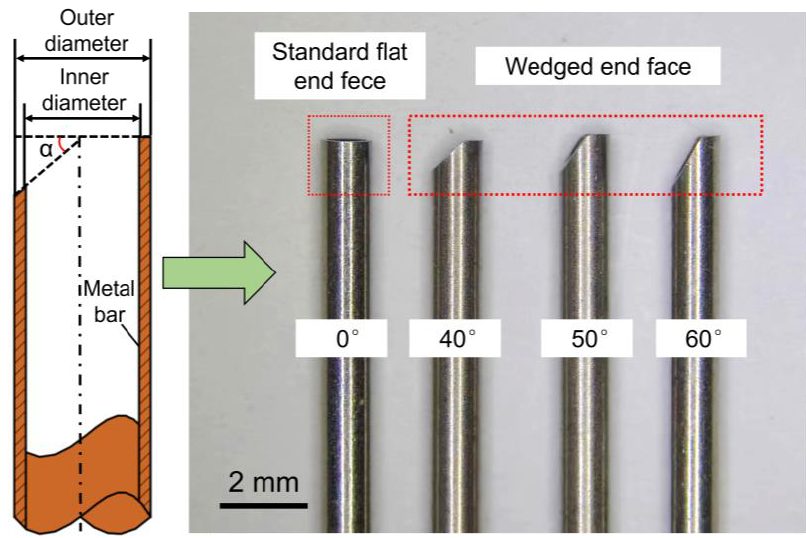
Figure 7. The photo of tube electrodes with different end faces.